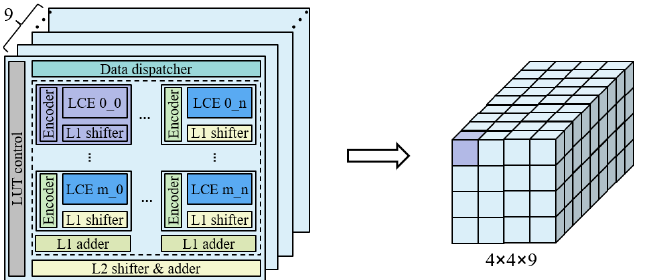
Figure 6. SC macro structure simplification. Each SC engine is represented by a small cube and the whole macro is converted to a large cube of dimensions 4 × 4 ×